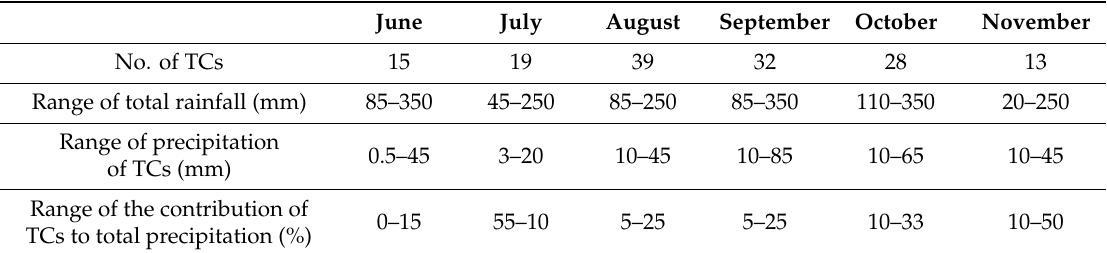
Figure 8. Monthly mean precipitation over Cuba (dashed blue line), the monthly mean precipitation attributed to TCs (continuous blue line), and the percentage that this represents (green bars). Data from Multi–Source Weighted–Ensemble Precipitation (MSWEP) for the period 1980–2016. Table 1. Number of TCs that a ff ected Cuba by month, range of total precipitation values across Cuba by month, range of rainfall associated with TCs across the country, and the percentage of these contributions. Period: